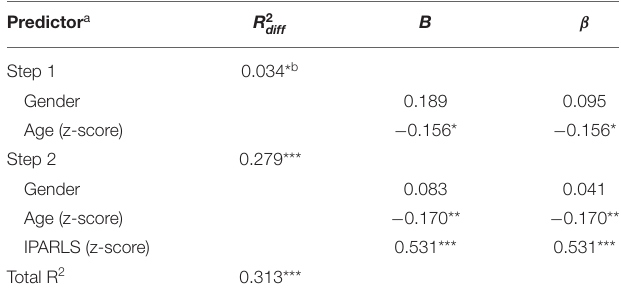
TABLE 5 | Descriptive statistics and Pearson’s correlations. a Variable